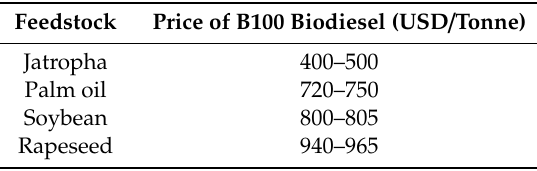
Table 2. A comparison of biodiesel prices from di ff erent feedstock (adapted from [36]).